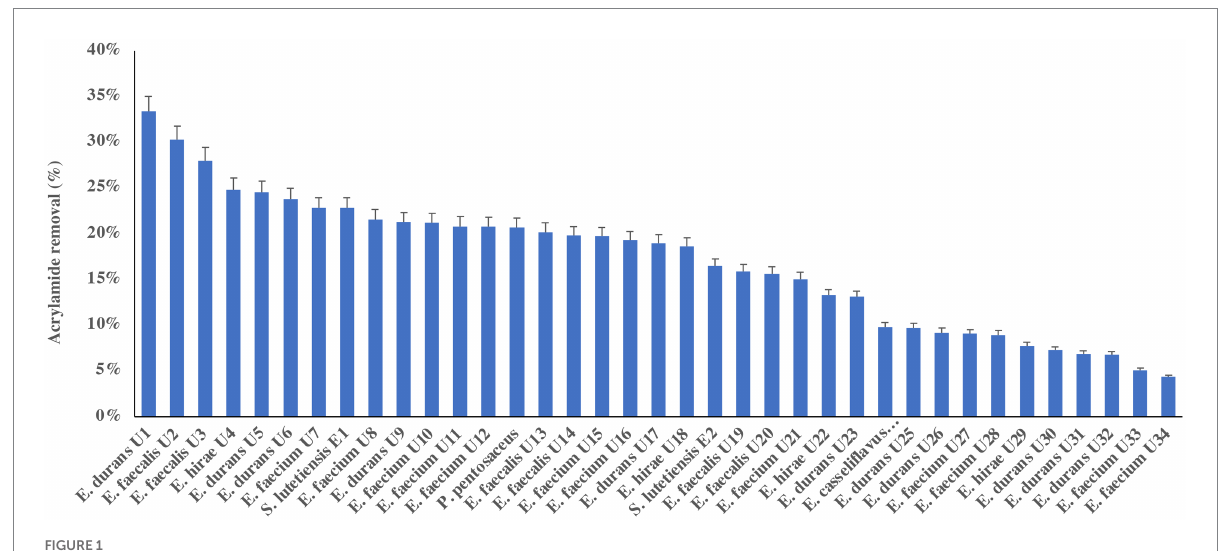
FIGURE 1 Acrylamide removal (%) by 38 lactic acid bacteria isolates. The bar value of triplicates. Error bars present the standard deviation.